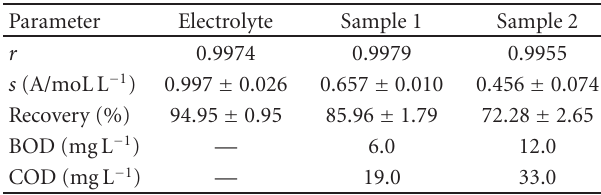
Table 2: Parameters from the analytical curves for 4-NP for the AgSAE in pure electrolyte and di ff erent natural water